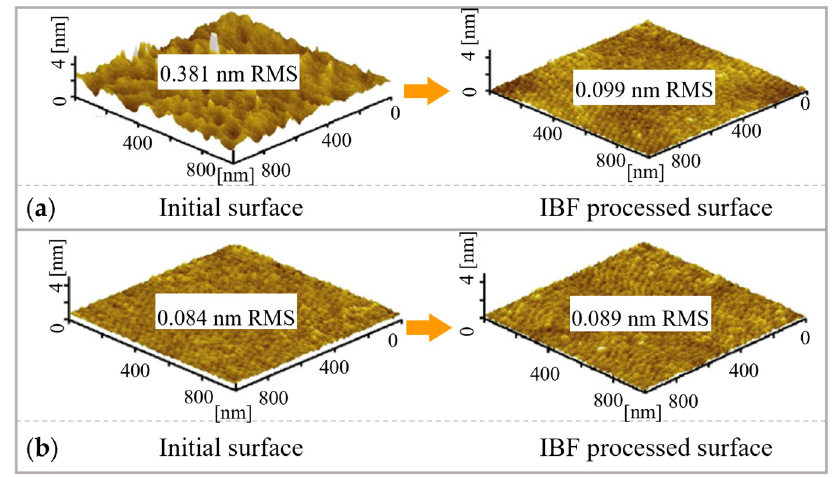
Figure 27. The IBF equipment developed by Nanotechnologie Leipzig GmbH [190].